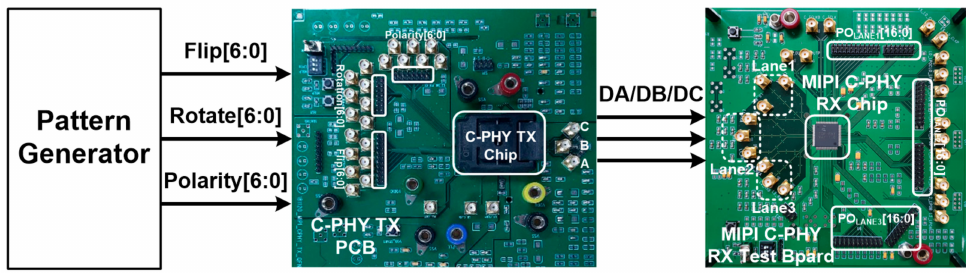
Figure 14. Test environment for evaluation of MIPI C-PHY receiver chip.